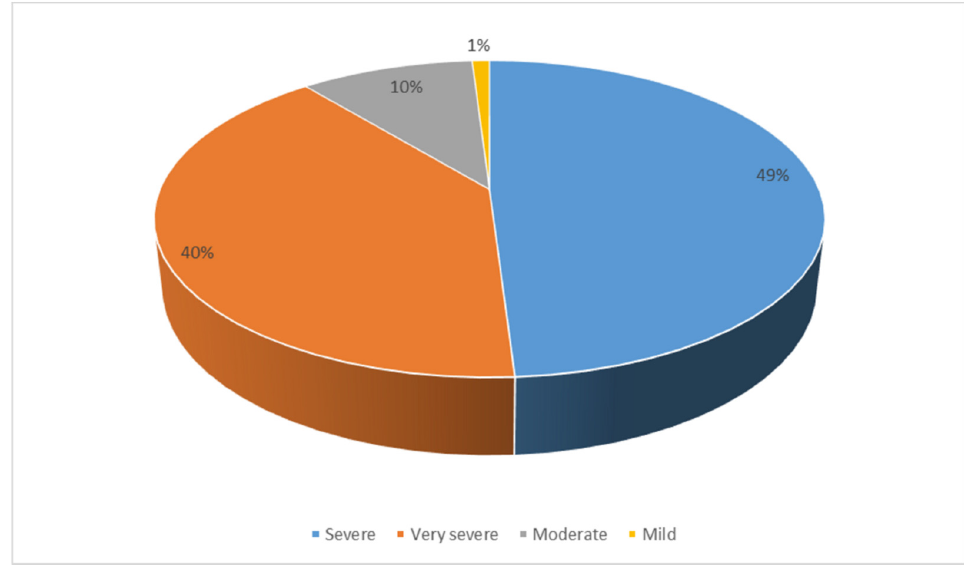
Figure 6. Degree of impact of fake news on society.